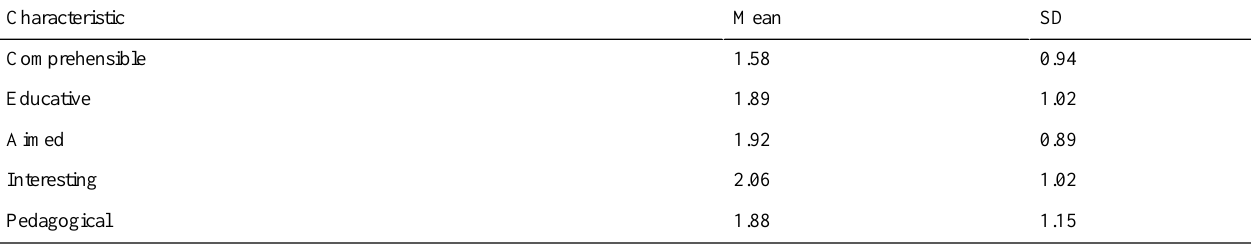
Table 6. Students’evaluation of the simulation scenario on a scale of 1 (extremely) to 5 (not at all)